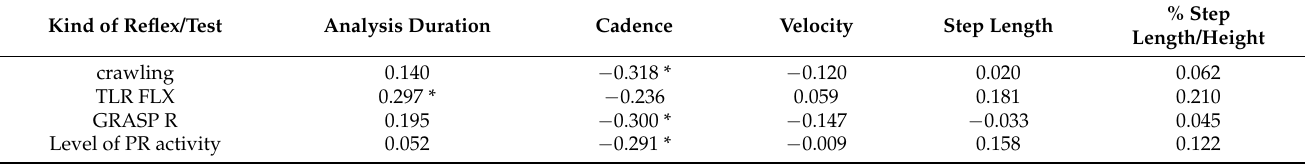
Table 3. Spearman’s correlations between selected reflexes and gait parameters such as duration, cadence, velocity, step length and proportion of step length and height.